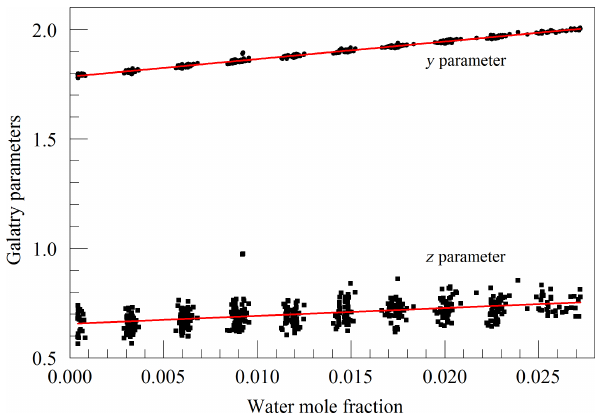
Figure 4. Galatry parameters of the 7816.75210cm − 1 water line in air at 340hPa and 45 ◦ C as a function of water mole fraction. Black points are from measurements and red lines are linear fits of y = 1 . 7846 + 8 . 01 × f H and z = 0 . 656 + 3 . 60 × f H 2 O 2 O